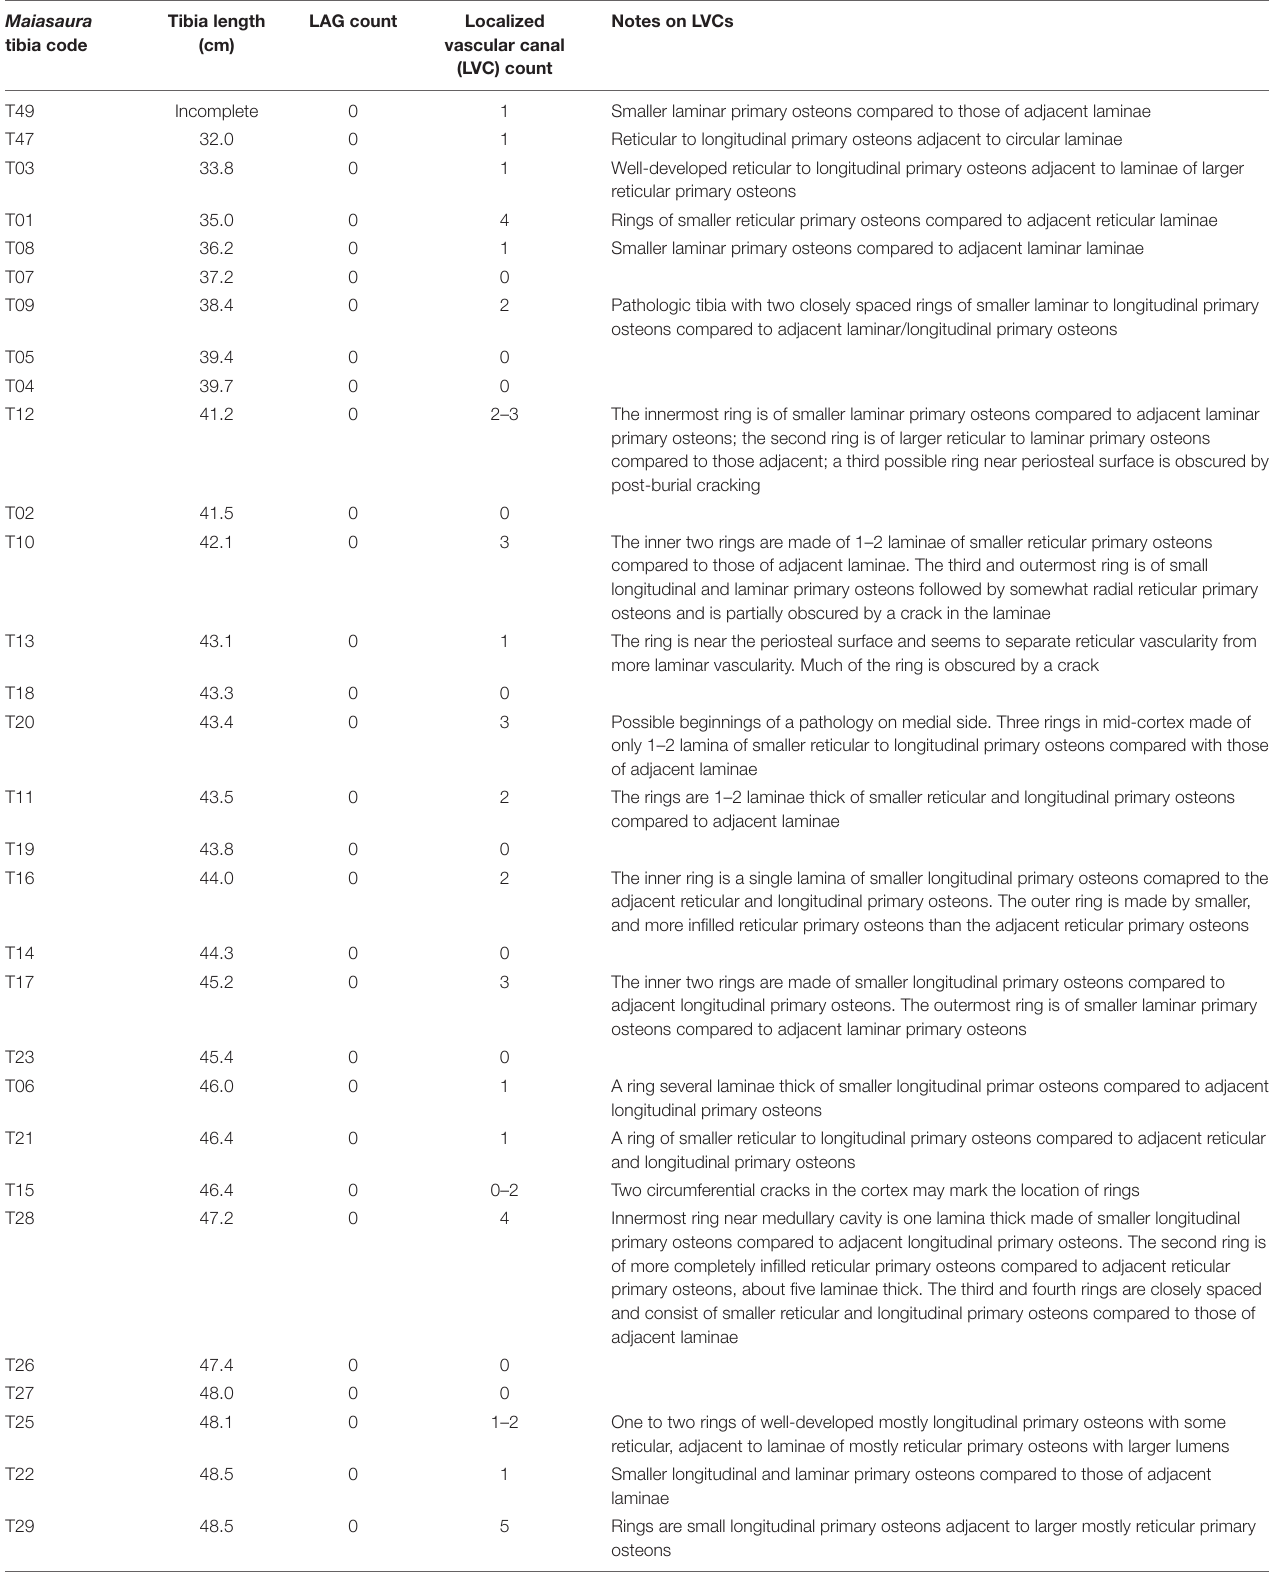
TABLE 1 | Documentation of Maiasaura tibia parameters relevant to this localized vascular change (LVC) assessment. Maiasaura Tibia length LAG count Localized tibia code (cm) vascular canal (LVC)